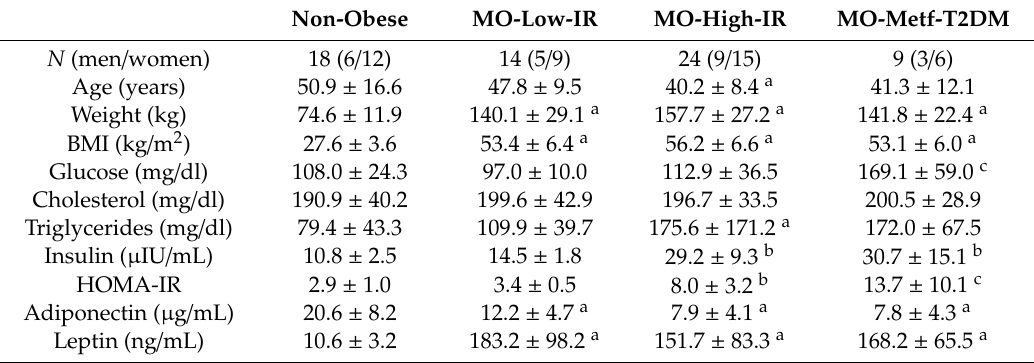
Table 1. Anthropometric and biochemical variables in patients included in the study. Non-Obese MO-Low-IR